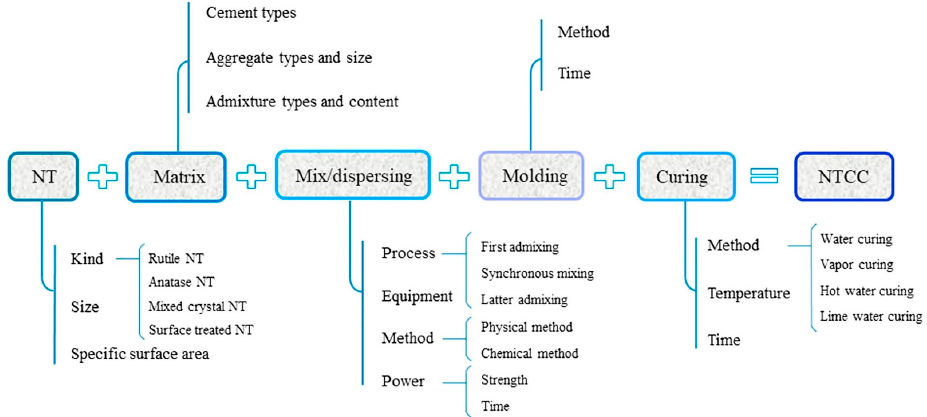
Figure 9. Schematic presentation of nano titanium dioxide/cementitious composites (NTCC) pro- duction methods. Reproduced from Li et al. [173] with permission from Elsevier.